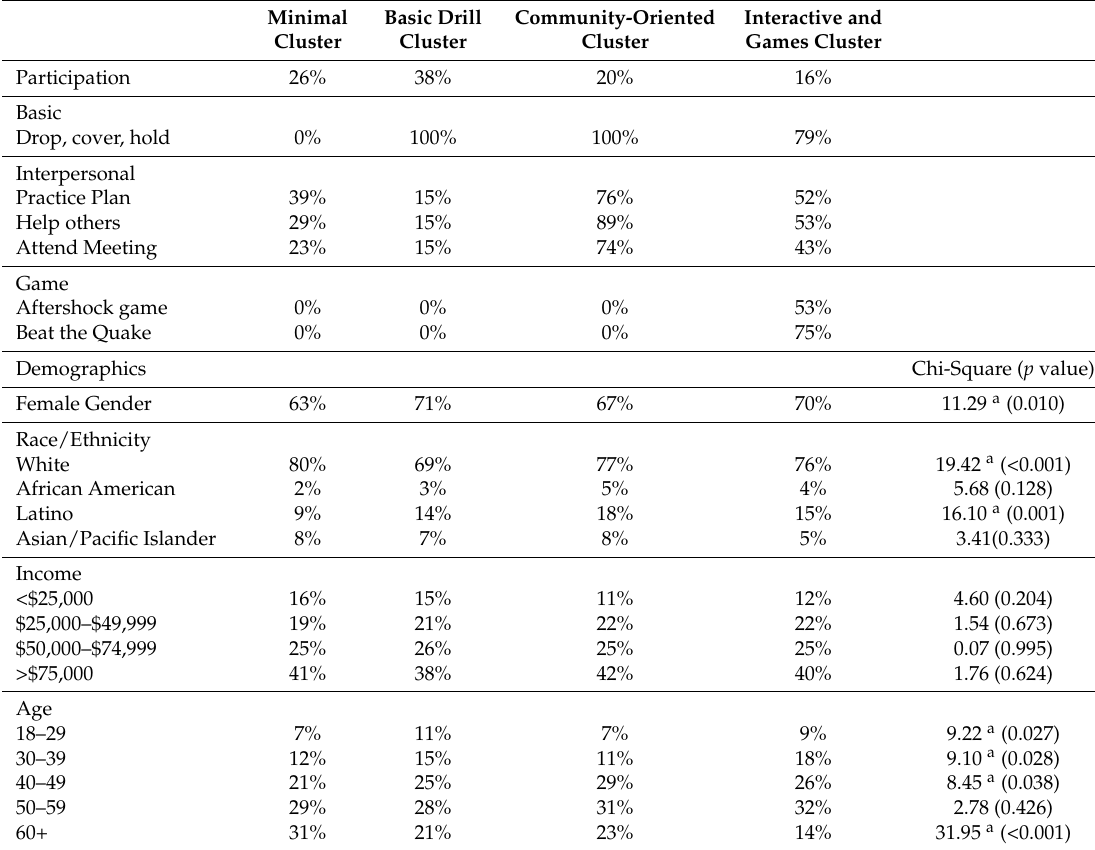
Table 3. Frequency distribution of ShakeOut activities and demographic variables in each derived cluster ( N = 2052).